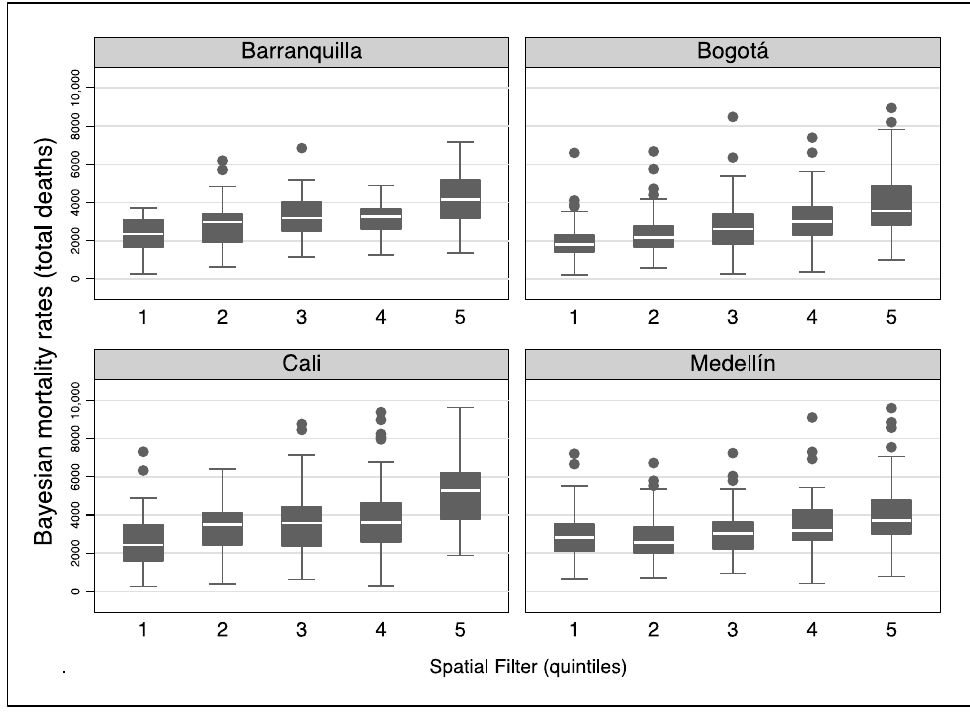
Figure 5. Geographic gradient of Bayesian mortality rates for all deaths across census sectors by the Moran eigenvector spatial filter quintiles by city in Colombia, 2015–2019.